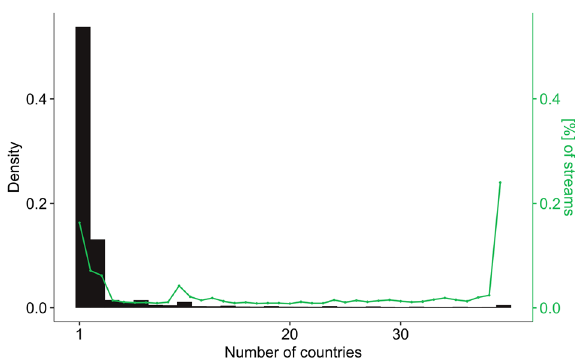
Fig. 1 Distribution of song ’ s internationalization. Bars represent the percentage of songs that got to the charts of exactly x countries. The green line represents the total number of streams that songs on each bin have accumulated while in the charts, as a measure of popularity in the period of analysis